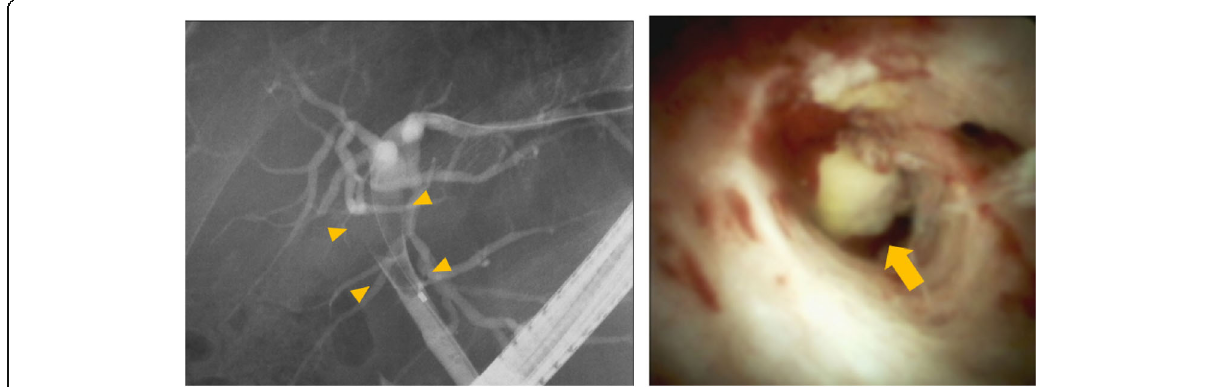
Fig. 3 Endoscopic retrograde cholangiopancreatography (ERCP) showed intrahepatic duct tumor thrombus within the right hepatic duct (B5-8) and B4 to the junction of the cystic duct (arrowhead). The tumor was observed by peroral cholangioscopy (POCS) (arrow)